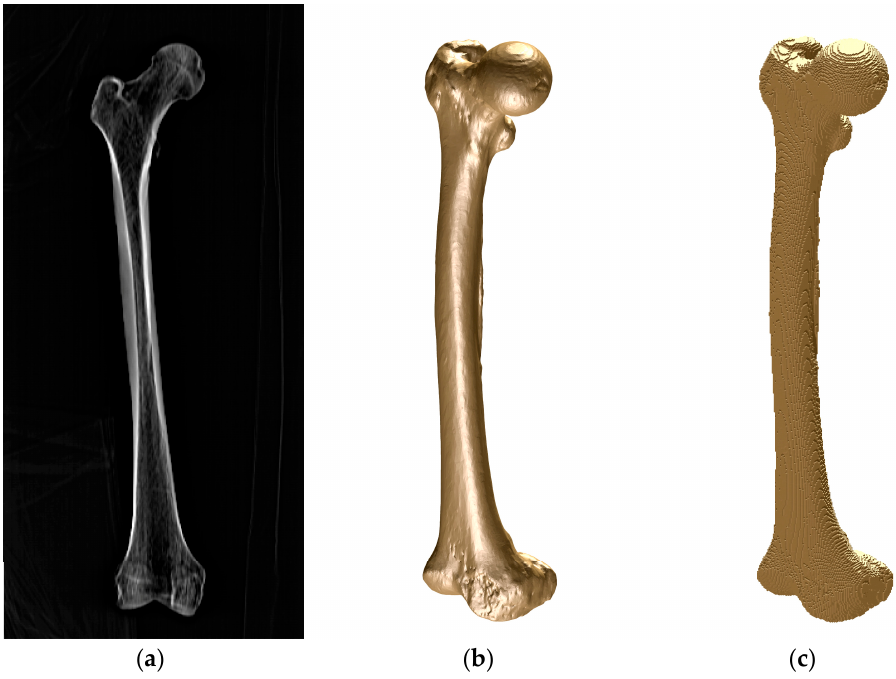
Figure 1. Femur of a 46-year-old man: ( a ) frontal MRI image; ( b ) CAD geometrical model; ( c ) voxel model.